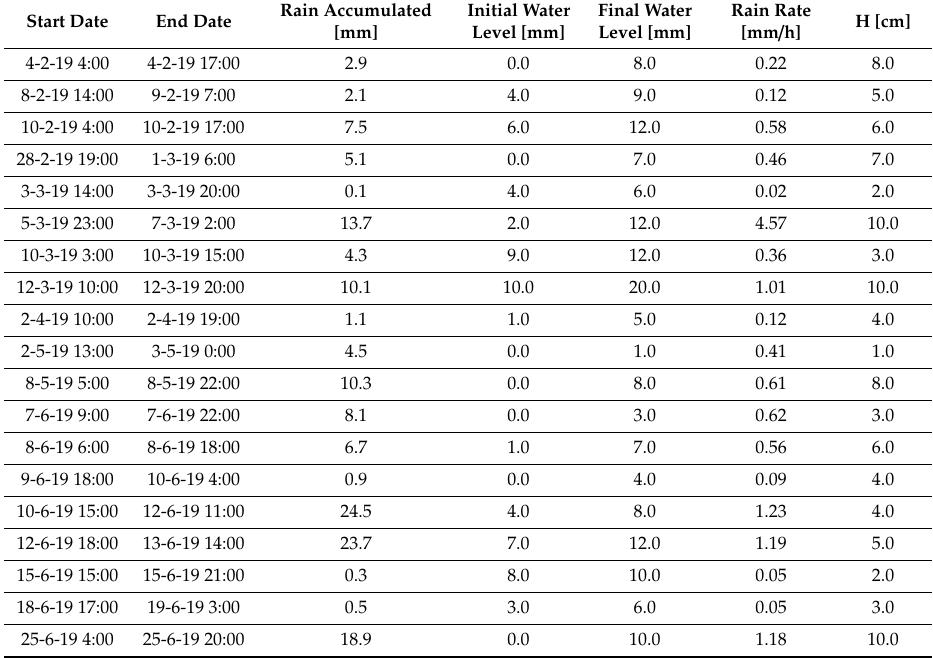
Table 5. Storm events captured during the 6 month period in 2019 and water level